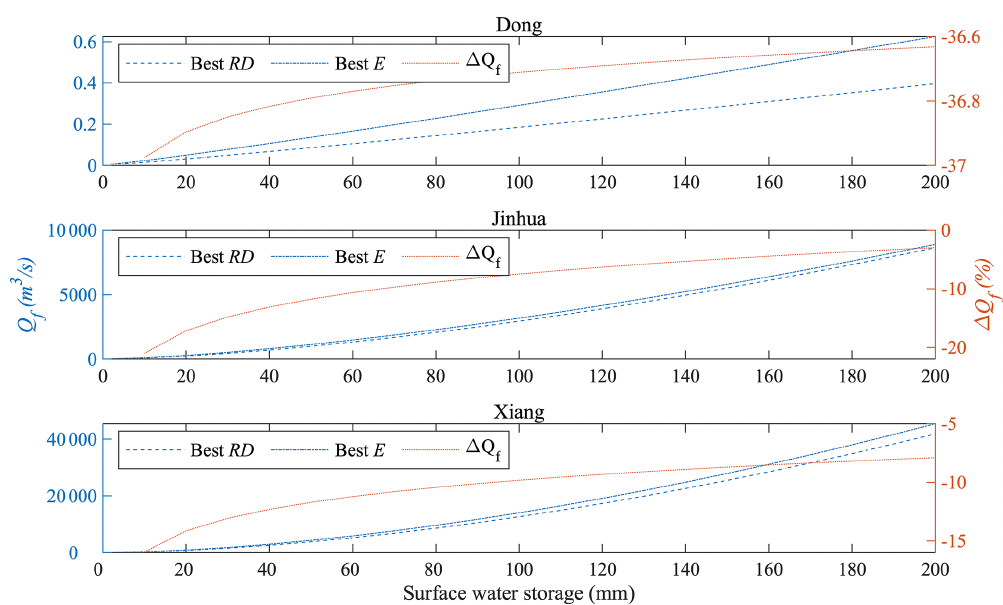
Figure 9. Response of fast flow to surface water storage. For each case, the fast flow responses of the typical models with the best RD and E are presented.